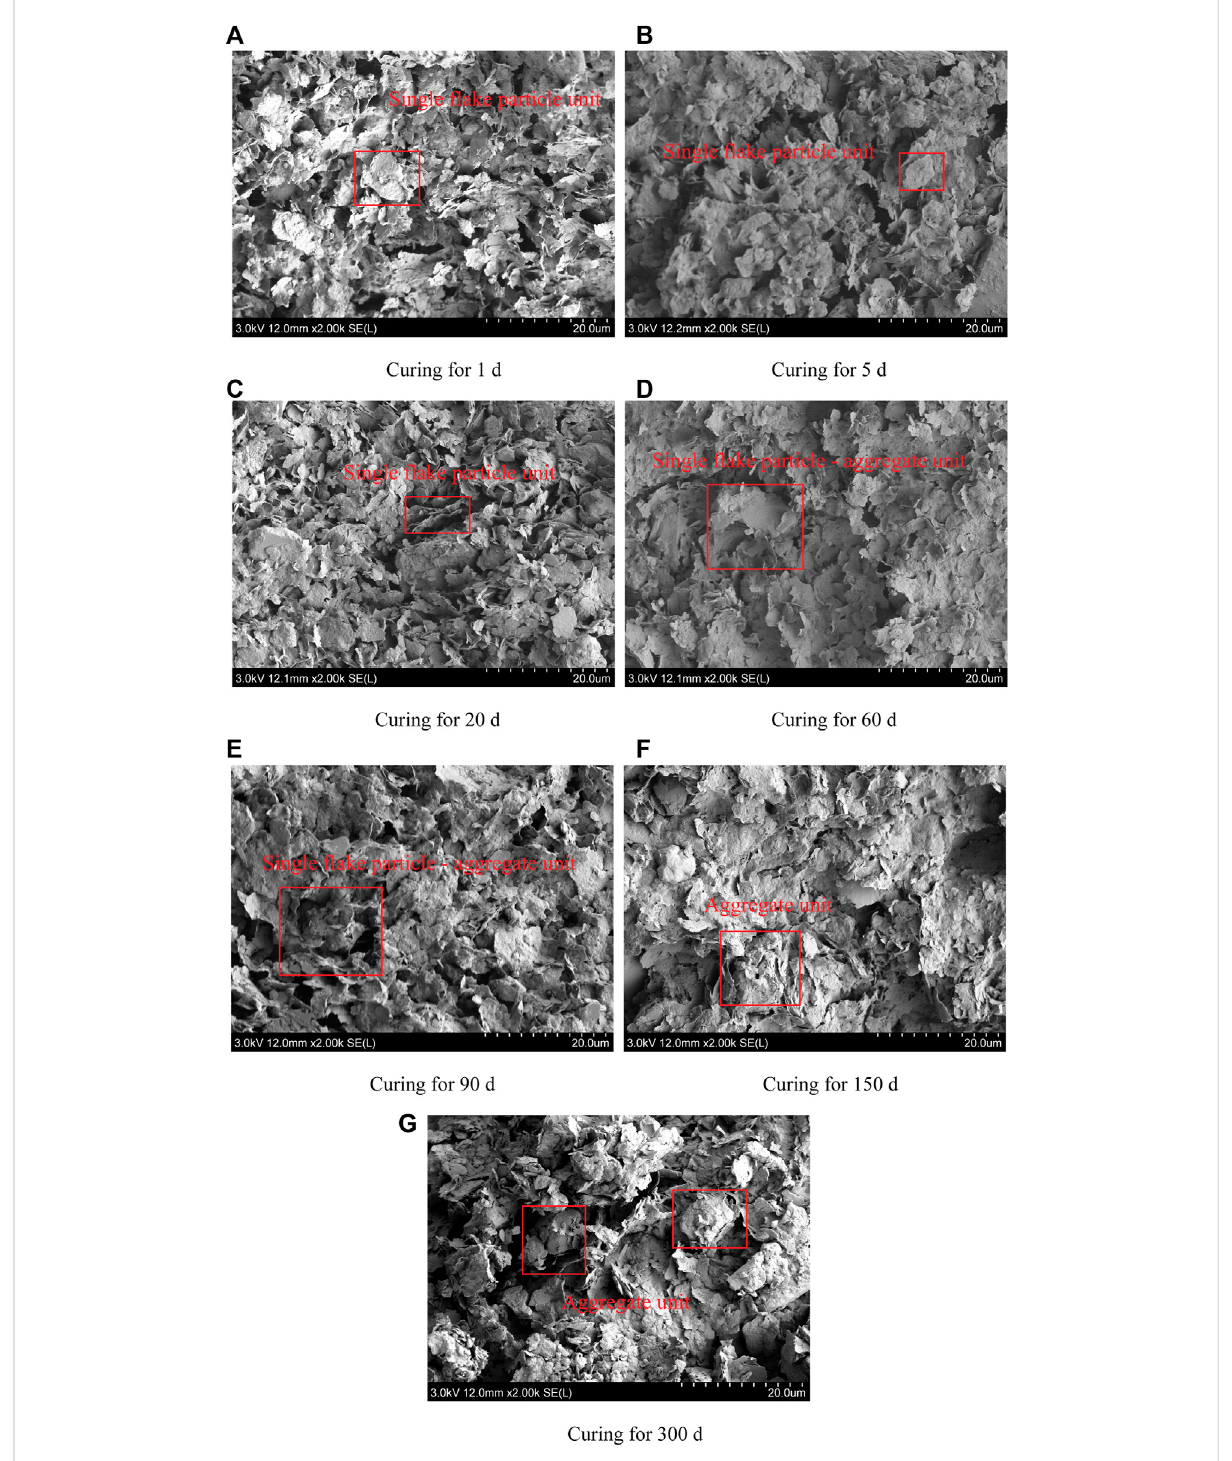
FIGURE 7 SEM photographs of reconstituted soil samples with different curing